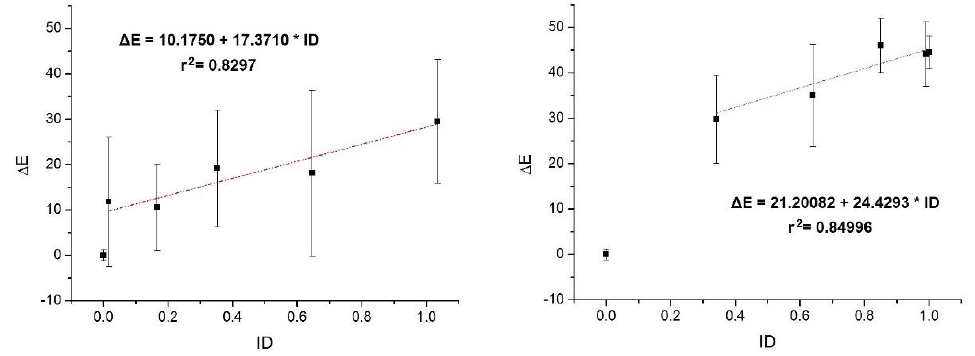
Figure 15. Comparison of ID and ΔE indices. ( Left ) specimens DC1 – DC5, ( Right ) specimens